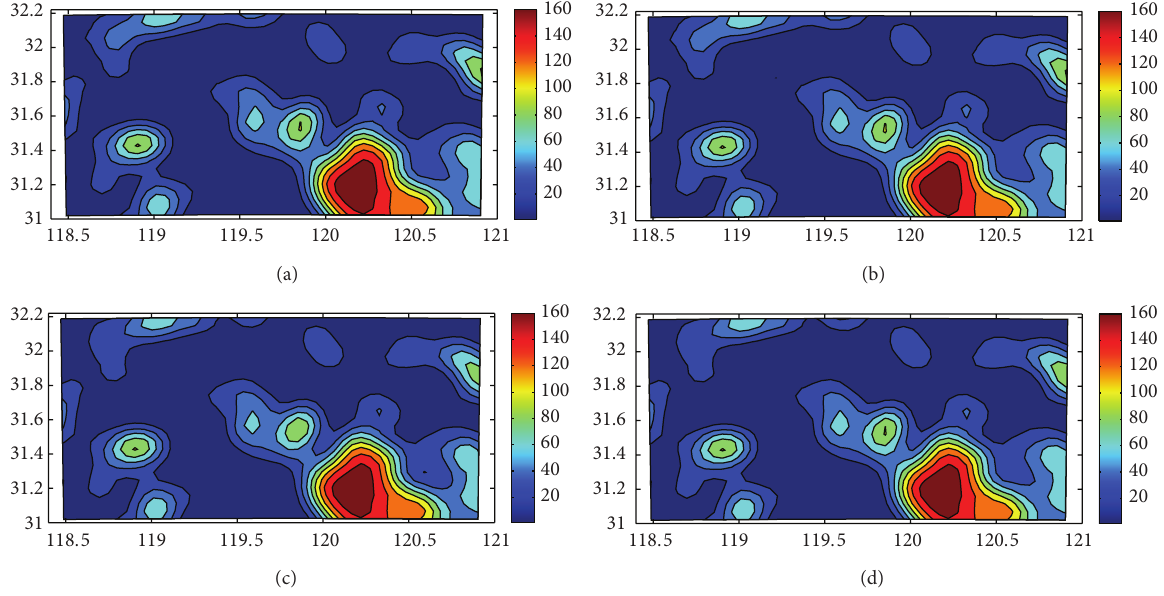
Figure 11: Spatial pattern of the latent heat flux in Southern-Jiangsu under different scenarios (unit: mm). (a) and (b) show the simulation result of latent heat flux of land use in Southern-Jiangsu in year 2010 under REG scenario and CES scenario, respectively; (c) and (d) show the simulation result of latent heat flux of land use in Southern-Jiangsu in year 2050 under REG scenario and CES scenario,